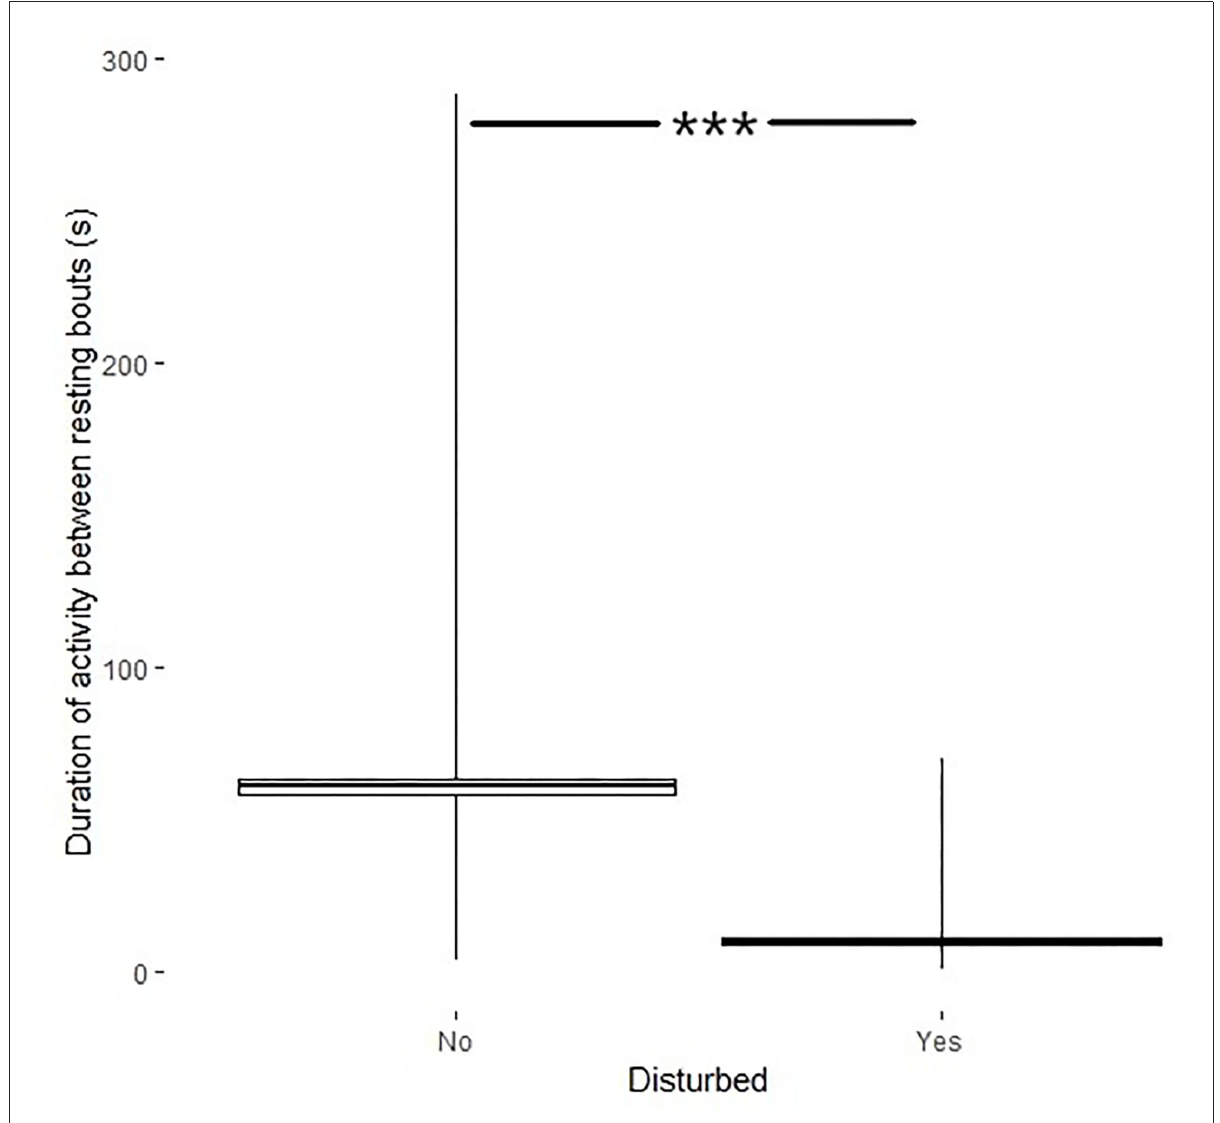
FIGURE5 Duration of activity between resting bouts (s, min–max + mean ± SE) if the bird was disturbed (yes) or not (no). *** Indicates significance level.